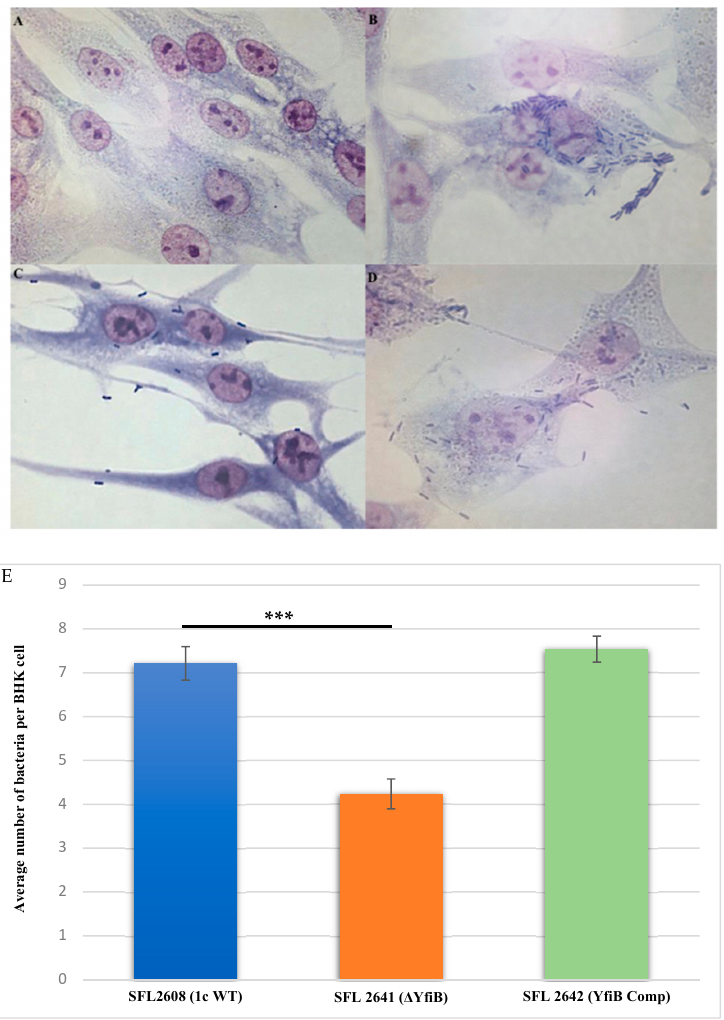
Figure 5. Invasion of BHK cell monolayers by S. flexneri strains. Microscopic images of infected BHK cells, after 2 h post infection at 37 ◦ C and at 5% CO 2 ; Giemsa stain was used to stain the monolayers, and the plates were observed under the microscope. ( A ) Microscopic image of noninfected BHK cells under 100 × oil immersion. ( B ) Microscopic image of BHK cells infected with the 1c WT (SFL2608) under 100 × oil immersion. ( C ) Microscopic image of BHK cells infected with yfiB KO mutant SFL2641 ( ∆ YfiB) under 100 × oil immersion. ( D ) Microscopic image of BHK cells infected with yfiB - complemented strain SFL2642 (YfiBComp) under 100 × oil immersion. ( E ) Shigella 1c WT (SFL2608), yfiB KO mutant SFL2641 ( ∆ YfiB), and yfiB -complemented strain SFL2642 (YfiBComp) were used to infect the BHK cells. The Y-axis represents the number of internalized bacteria per BHK cell after 2 h post-infection at 37 ◦ C/5% CO 2 . The results were obtained from three independent experiments and were derived from scoring at least 300 BHK cells. To analyze the statistical differences in the invasion, a Student’s t -test was performed. Three asterisks represent that the variance observed was statistically significant ( p < 0.001) and standard deviation of data from three autonomous experiments is depicted by the error